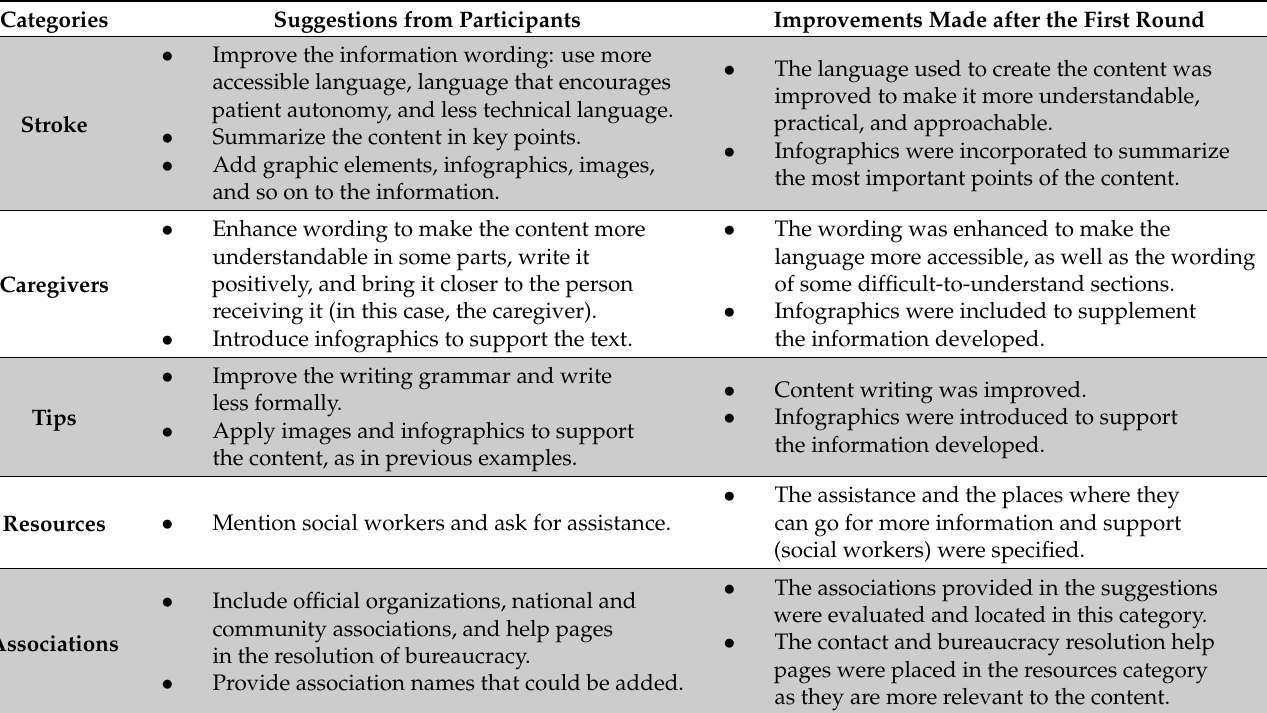
Table 6. Suggestions and improvements made to the content after the first round of